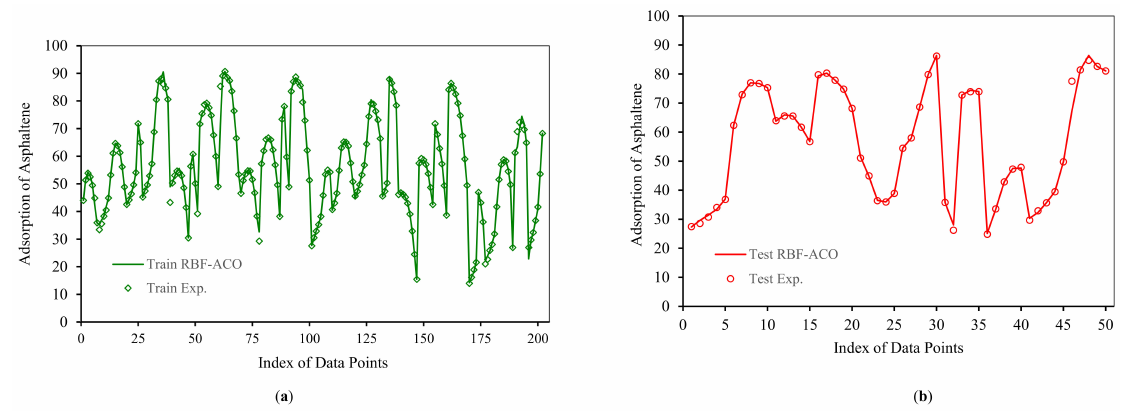
Figure 12. Comparison between predicated and experimental asphaltenes adsorption by RBF-ACO for ( a ) Train; ( b ) Test.